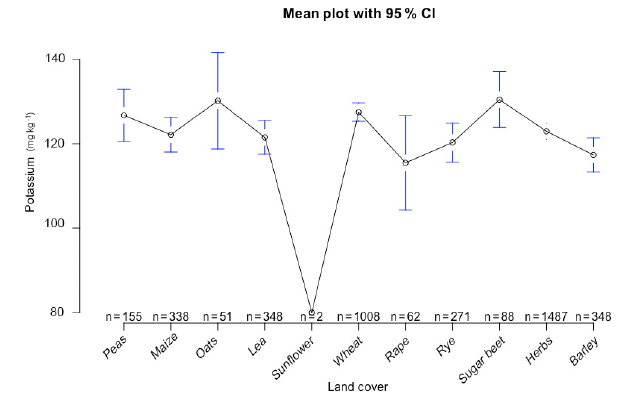
Figure 4. The ANOVA results between the culture and the potas- sium content in the